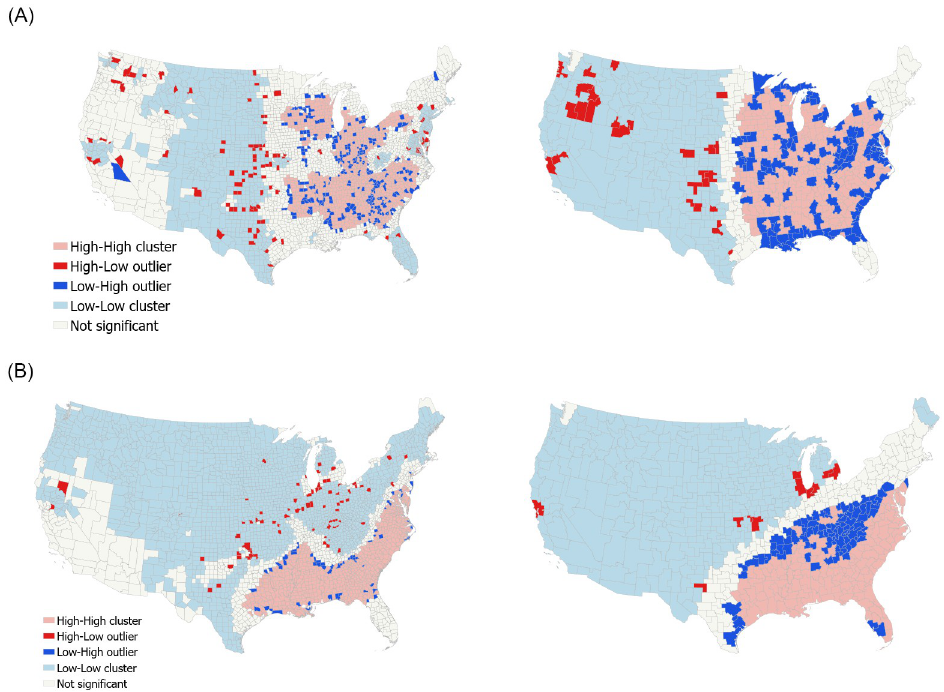
Fig 1. a. LISA Cluster Map for Spatial Autocorrelation (counties left, CZs right); NAICS 31–33 (Manufacturing). b. LISA Cluster Map for Spatial Autocorrelation (counties left, CZs right); Percent identifying as Black Note :